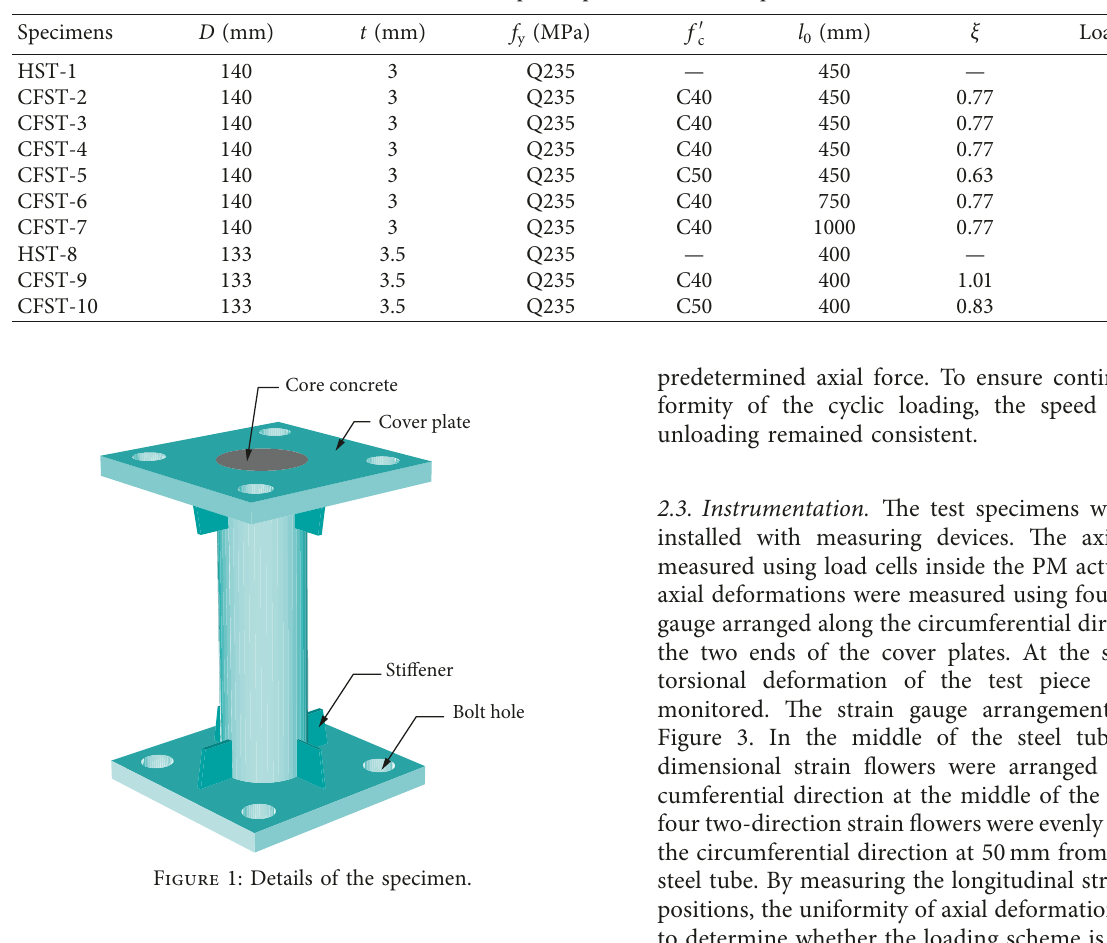
Table 1: Specific parameters of the specimens.